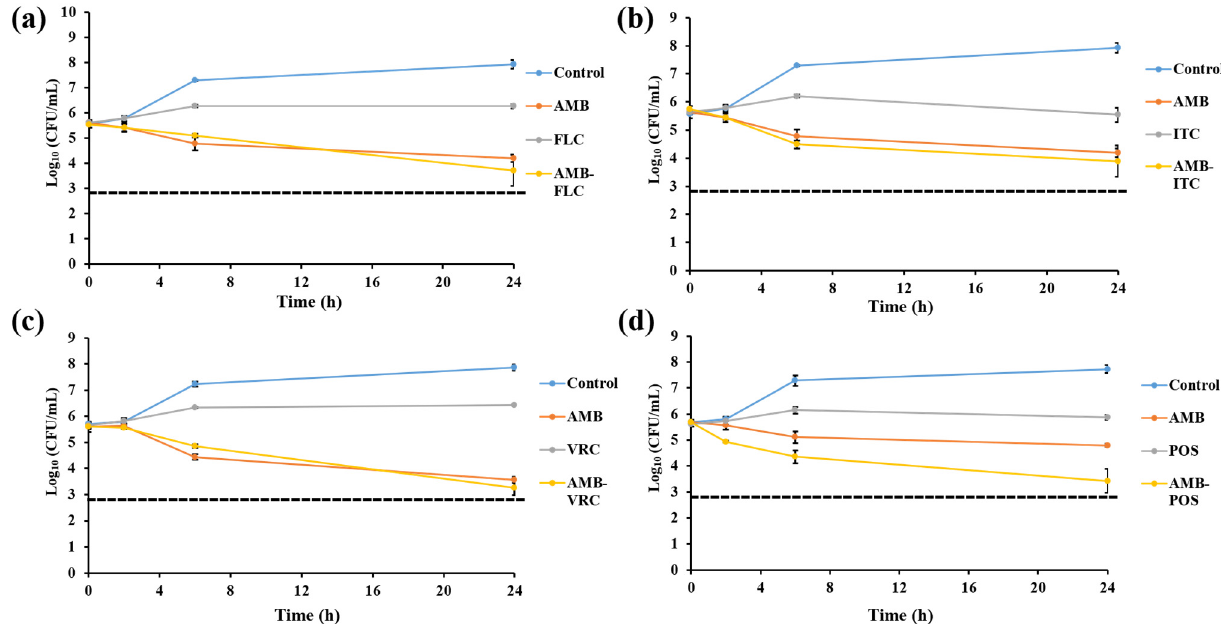
Figure 4. In vitro activities of AMB (1 µ g/mL) alone and in combination with FLC 25 µ g/mL; ( a ), ITC 4 µ g/mL; ( b ), VRC 1 µ g/mL; ( c ), and POS 4 µ g/mL; ( d ) against C. glabrata IFM60089 as determined by the time-killing assay. The detection limit was 20 CFU/mL. Dashed lines represent a >99.9% growth reduction compared with the initial inoculum size for determination of fungicidal activity. All AMB combinations with azoles showed indifferent interactions. Each data point represents the means ± standard deviation of results from two independent experiments.